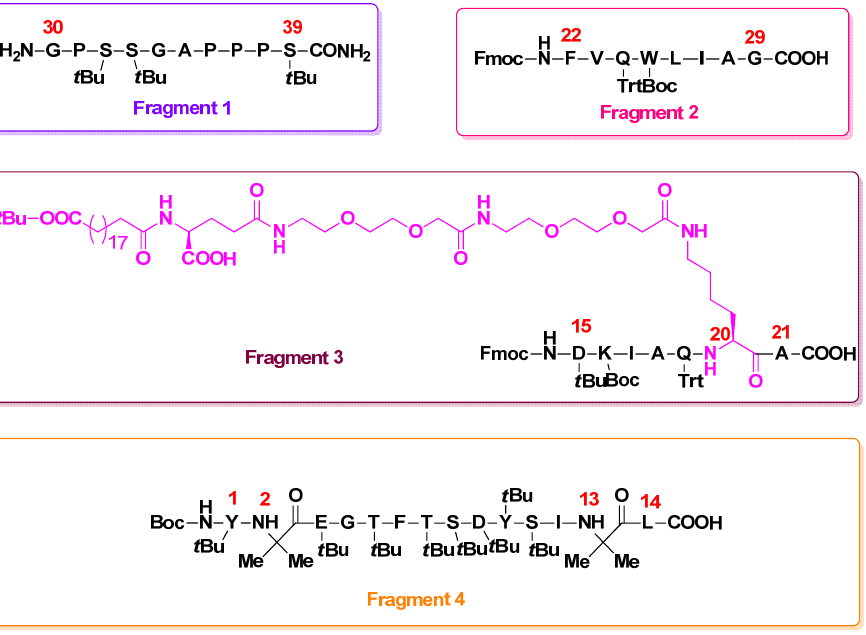
Figure 3. Fragments used to synthesize tirzepatide using the SPPS/LPPS